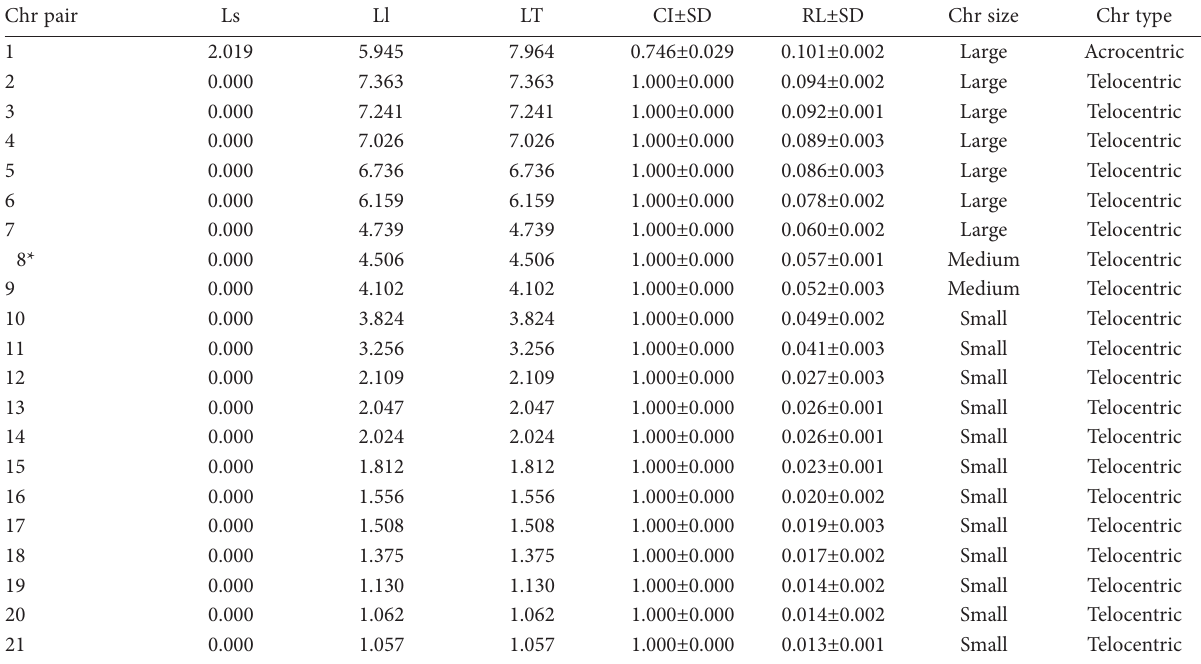
Table 3. Mean length of short arm chromosome (Ls), long arm chromosome (Ll), length of total chromosomes (LT), centromeric index (CI), relative length (RL) and standard deviation (SD) of CI and RL from 20 metaphases of male and female dark-sides ground gecko ( Dix- onius melanostictus ),